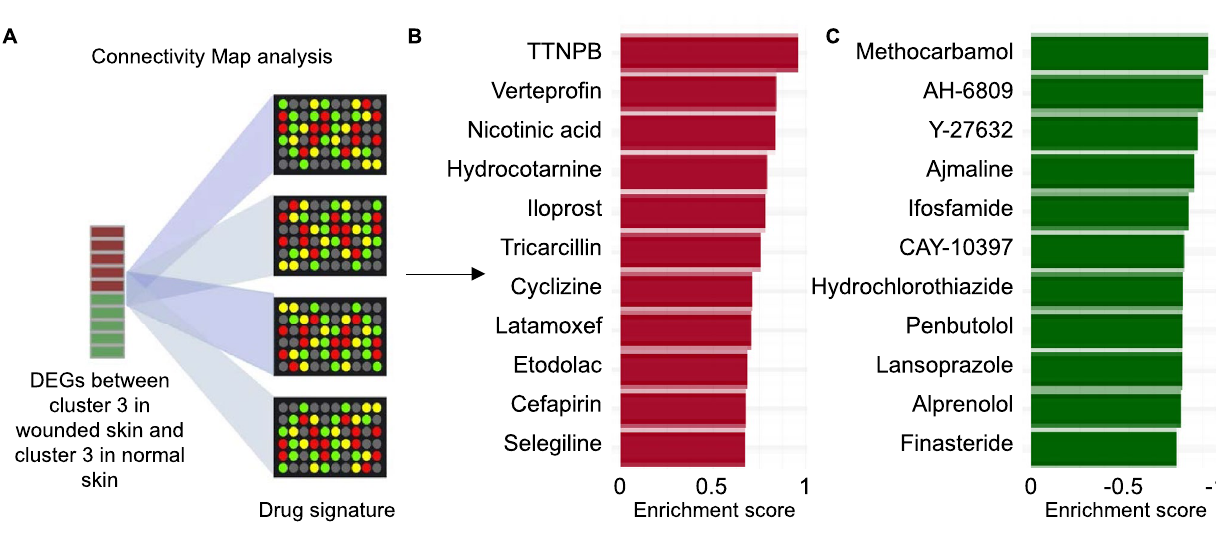
Figure 5. Identification of drugs mimicking or counteracting the differential expression pattern in cluster 3 during wound healing. ( A ) The similarity between the DEGs between cluster 3 cells in wounded skin and cluster 3 cells in normal skin with log2FC ± 0.25 were checked with the signature of each of the 6,100 drug/ compound instances in the Connectivity Map database. ( B ) The top identified drugs having signature that mimics the differential expression pattern in cluster 3 in wounded skin (positive enrichment). ( C ) The top identified drugs having signature that counteracts the differential expression pattern in cluster 3 in wounded skin (negative